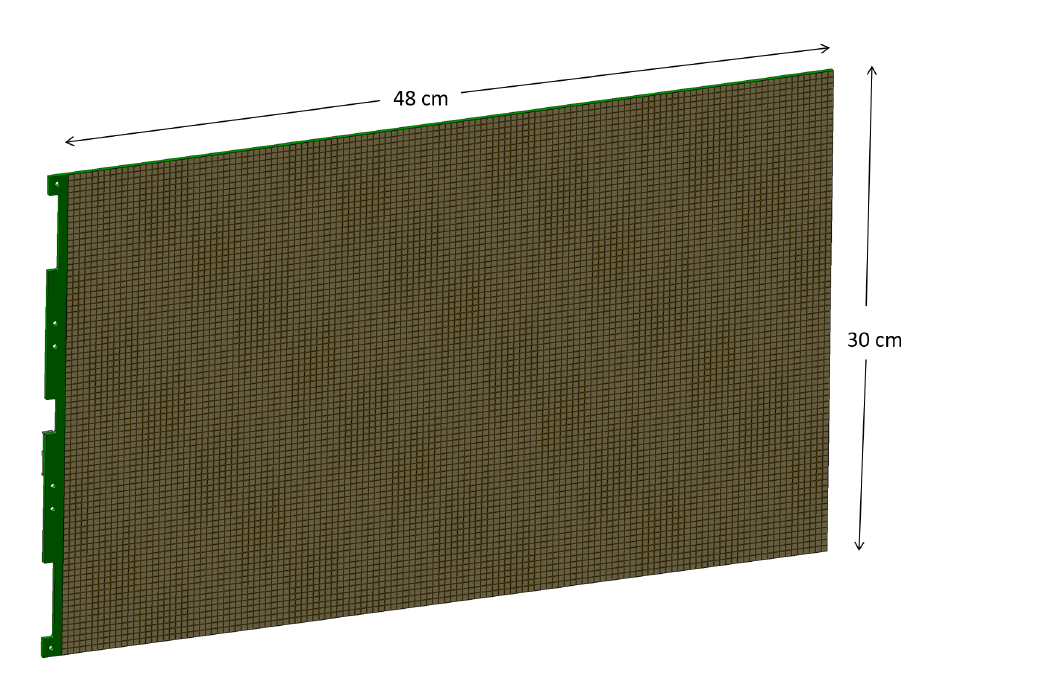
Figure 7. The LArPix pixel anode tile with 10,240 self-triggering charge-sensitive pixels. Each TPC anode is composed of 20 identical tiles arranged in two columns.